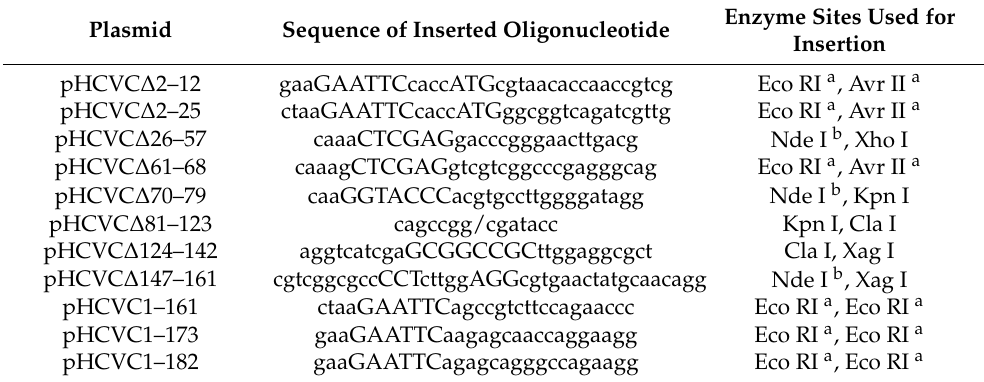
Table 1. Construction of HCV core mutants. Plasmid Sequence of Inserted Oligonucleotide